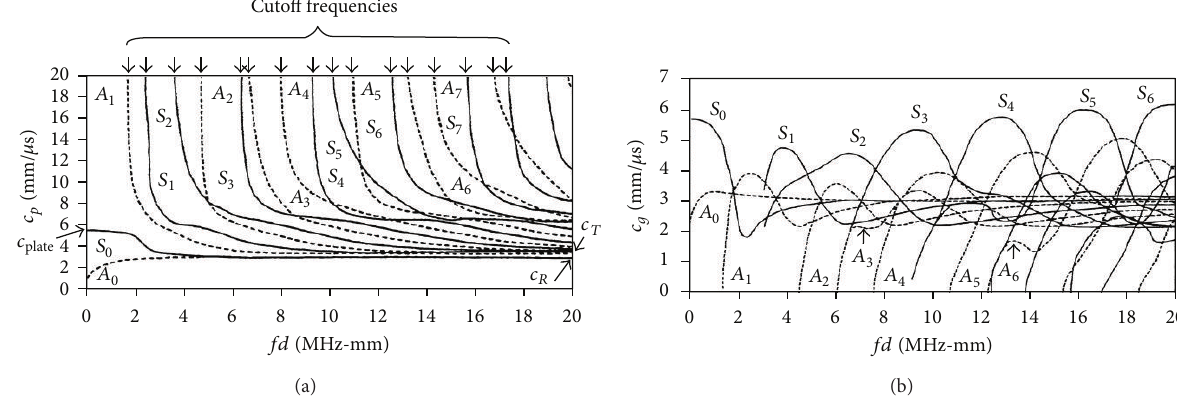
Figure 1: Dispersion curves for a traction free aluminum plate (the classic Lamb wave problem): (a) phase velocity dispersion curvesa and (b) group velocity dispersion curves [1, 2].